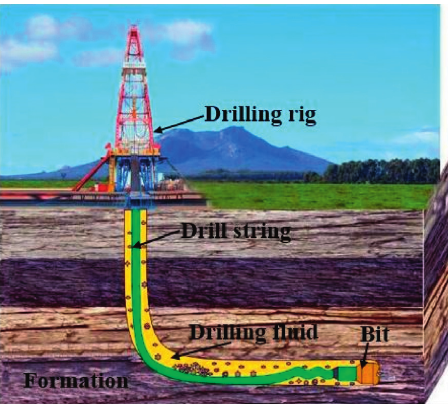
Figure 1: Schematic of rotary drilling from authors’ prior work